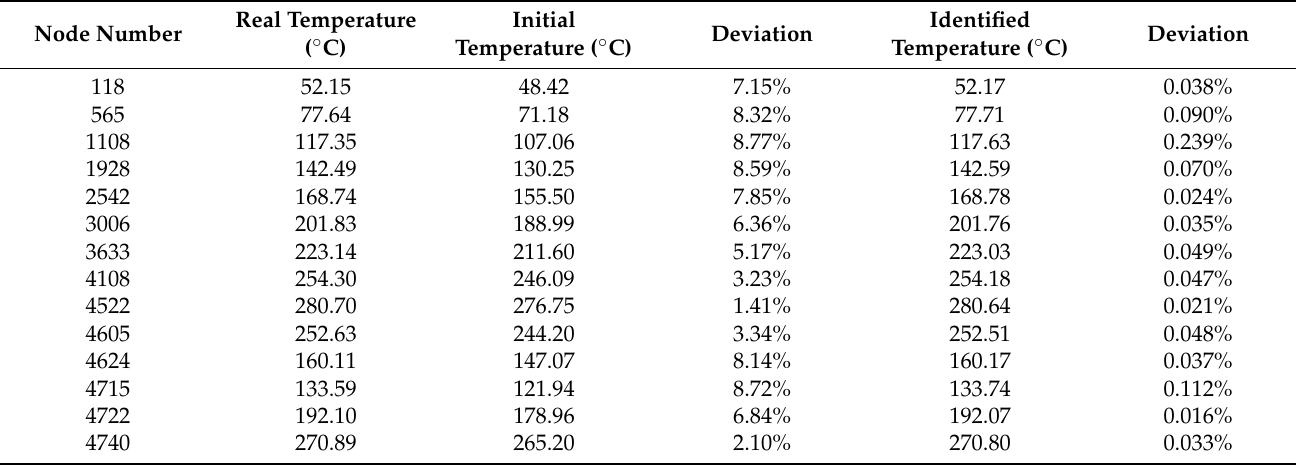
Table 10. The comparison of real temperature, initial temperature and identified temperature.